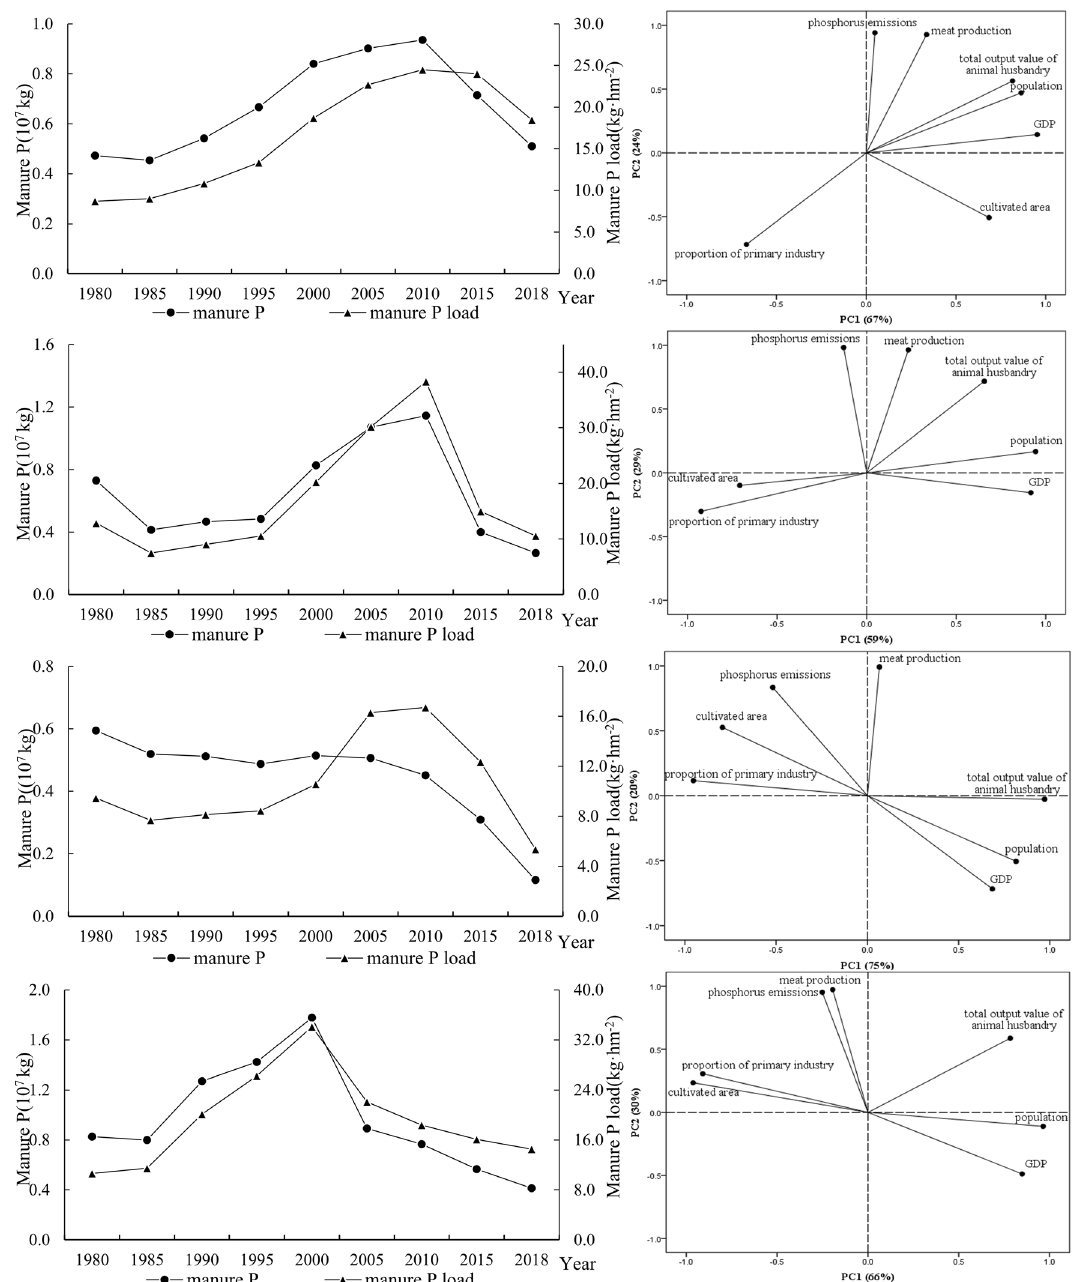
Figure 10. Manure P emissions from 1980 to 2018 and main control factors based on principal component